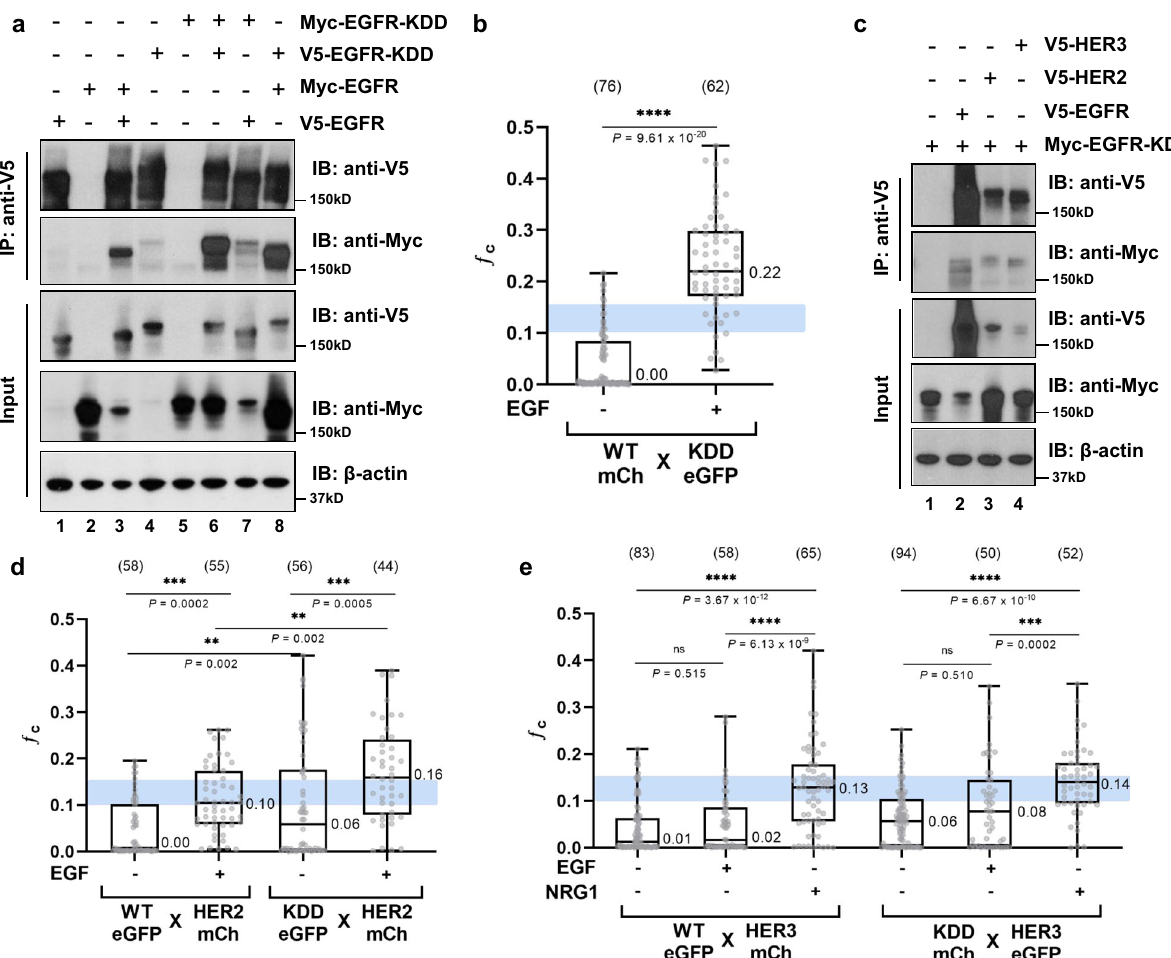
Fig. 4 EGFR-KDD directly interacts with ERBB family members. a V5-epitope-tagged EGFR-WT and EGFR-KDD was co-transfected with Myc-epitope- tagged EGFR-WT and EGFR-KDD in HEK293 cells. After 48 h transfection, cells were lysed by hypotonic buffer and the cell lysates were immunoprecipitated by using V5 antibody. Immunoblotting were probed by V5 and Myc antibody. b Cross-correlation values of co-transfected EGFR-WT (mCherry-fused) and EGFR-KDD mutant (eGFP-fused) with ( + ) or without ( − ) ligand (EGF) stimulation is shown. The light blue box indicates the ƒ c value region for dimers. c Myc-epitope-tagged EGFR-KDD was co-transfected with V5-epitope-tagged EGFR-WT, HER2, and HER3 in HEK293 cells. Cell lysates were immunoprecipitated by using V5 antibody. Immunoblotting were probed by V5 and Myc antibody. d Cross-correlation values of co-transfected HER2 (mCherry-fused) and EGFR-KDD mutant (eGFP-fused) with ( + ) or without ( − ) ligand (EGF) stimulation is shown. e Cross-correlation values of co- transfected HER3 (mCherry-fused) and EGFR-KDD mutant (eGFP-fused) with ( + ) or without ( − ) ligand (EGF) stimulation is shown. For a and c , n = 2 experiments were repeated independently with similar results. Results are the representative of two independent experiments. For b , d and e , data are reported as box and whiskers plot, the whiskers show the maximum and the minimum; the box shows 25th – 75th percentile; and the line in the box is the median value. The median values are reported next to the boxplot. Each gray dot represents the averaged acquisition (10 s, 6 acquisitions) per area per cell. All data points are shown. Numbers in parenthesis above the boxplot are the total number of cells where data were taken on. One-way ANOVA test with uncorrected Fisher ’ s LSD post hoc test were performed to obtain adjusted and individual P values. Data are presented as median values ± SD. For a – e , source data are provided as a Source Data fi